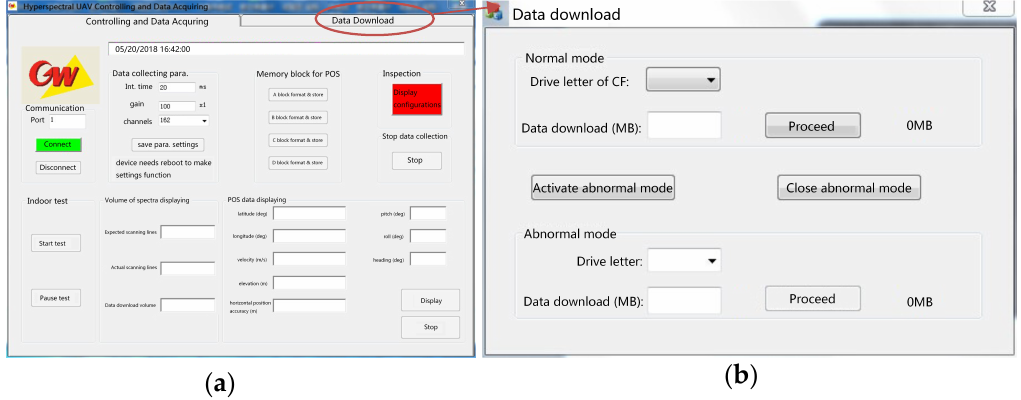
Figure 4. Interface of ( a ) data acquisition software and ( b ) data transfer